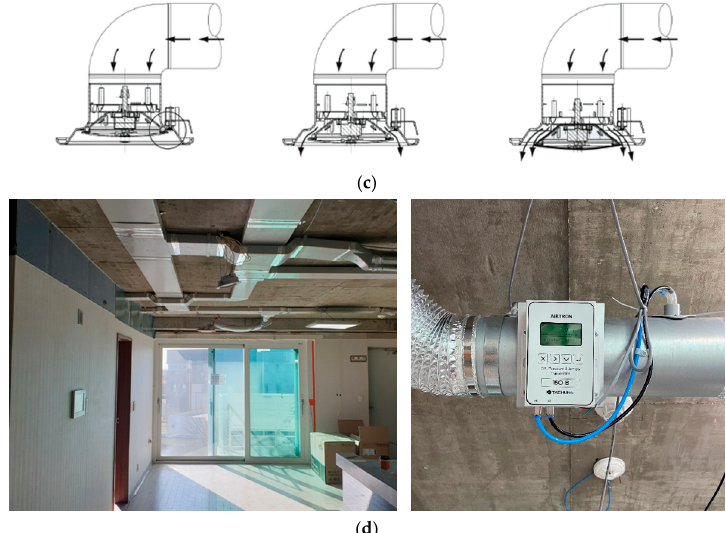
Figure 1. Target space and system. ( a ) Floor plan and duct configuration of the HRV. ( b ) Diagram of the HRV system. ( c ) VAV diffuser (left: Fully closed, middle: partially opened, right: Fully opened). ( d ) LR of the target space (left) and the FMS.